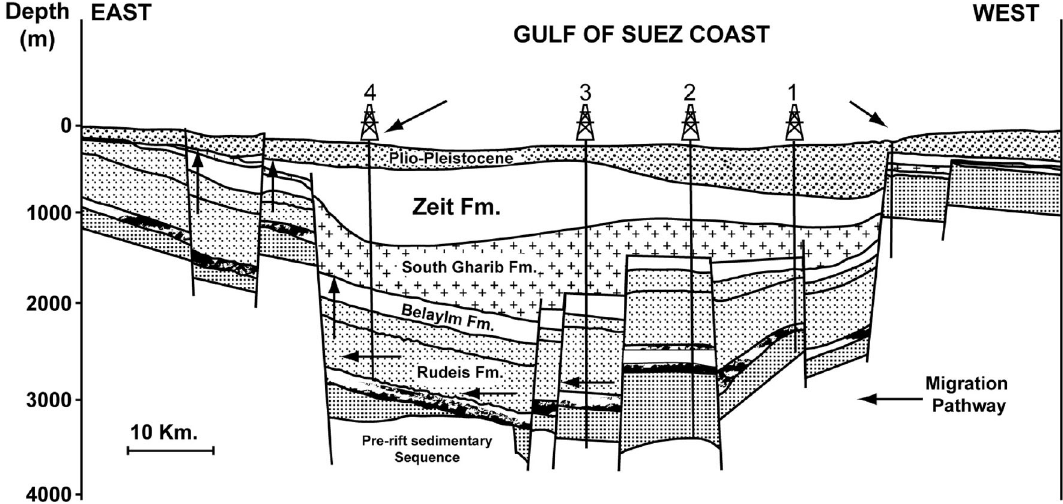
Fig. 2 Cross section showing the intensely faulted Gulf of Suez (Modified after Younes